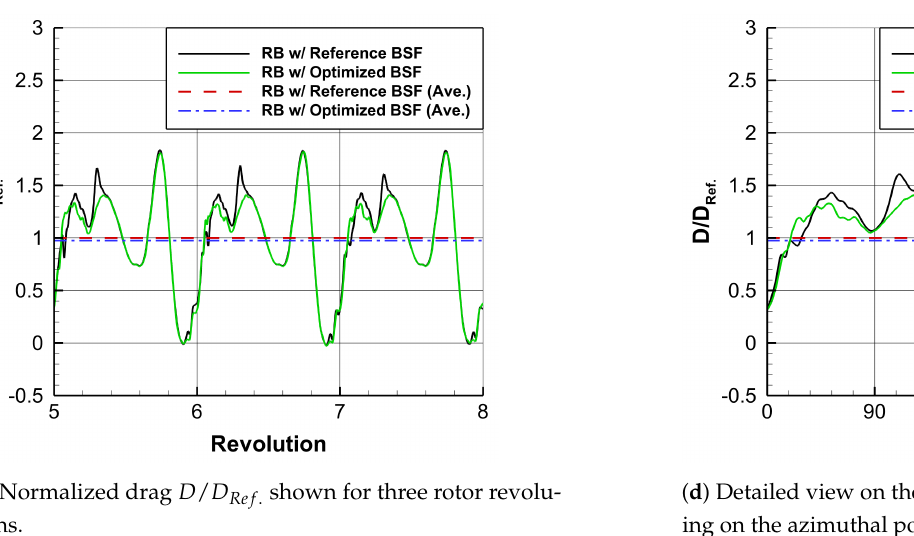
Figure 15. Comparison of the aerodynamic forces for a single rotor blade (RB) in combination with the optimized and the reference BSF. The forces are normalized by the average values of the RB combined with the reference